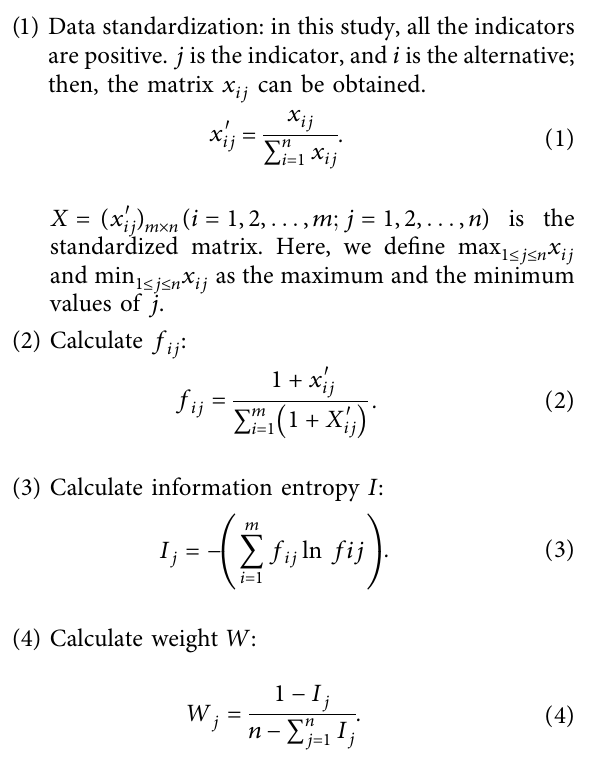
Table 1: Indicators of the 7E framework. Aspect Indicator